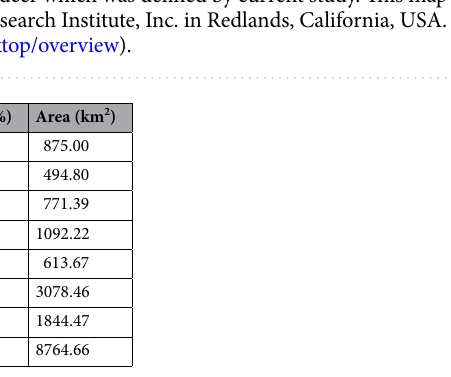
Table 4. Potential distribution area of water deer in various cities/counties in Northeast